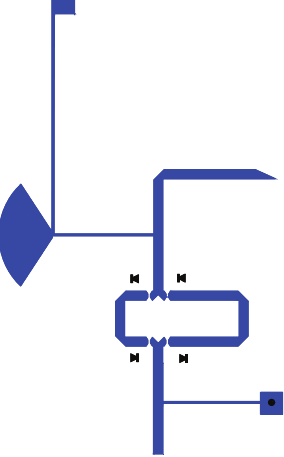
Figure 1: Antenna architecture.